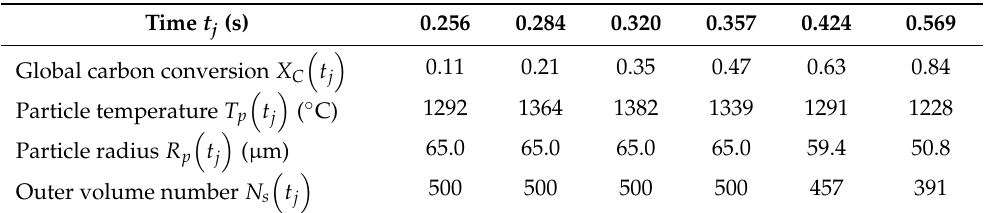
Table 3. Calculated quantities at six times of the combustion of a coal char particle in the drop tube furnace. Regulation temperature: 1200 ◦ C. Time t j (s) 0.256 0.284